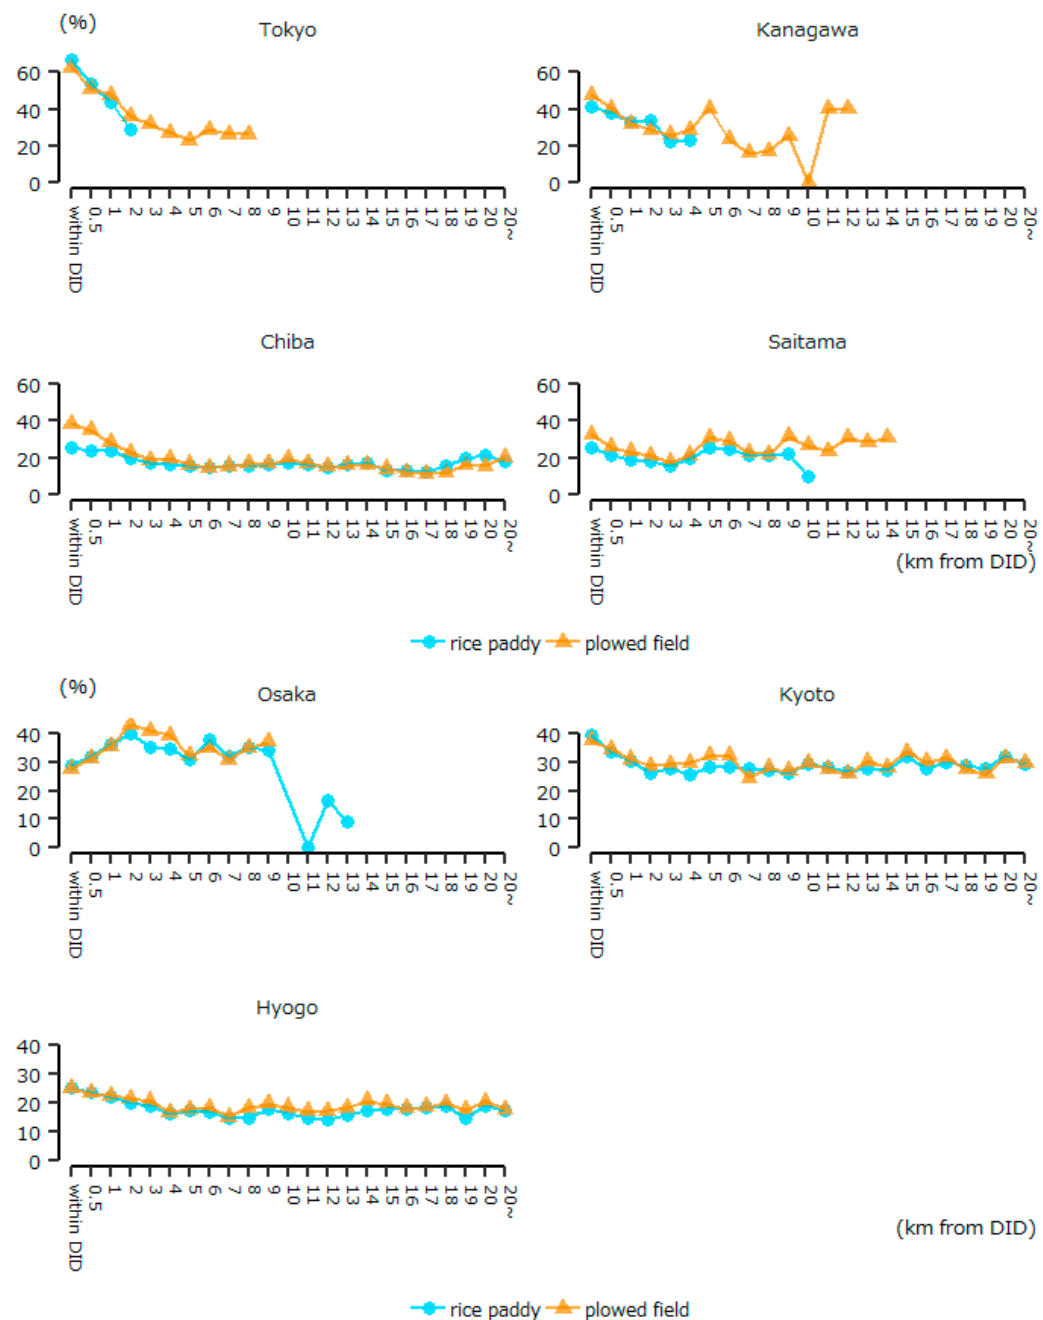
Figure 10. Average diversified farms rate of each prefecture by distance from DID. Note: The average diversified farms rate is calculated by relating the rate per agricultural community unit to farmland parcels, using GIS software.